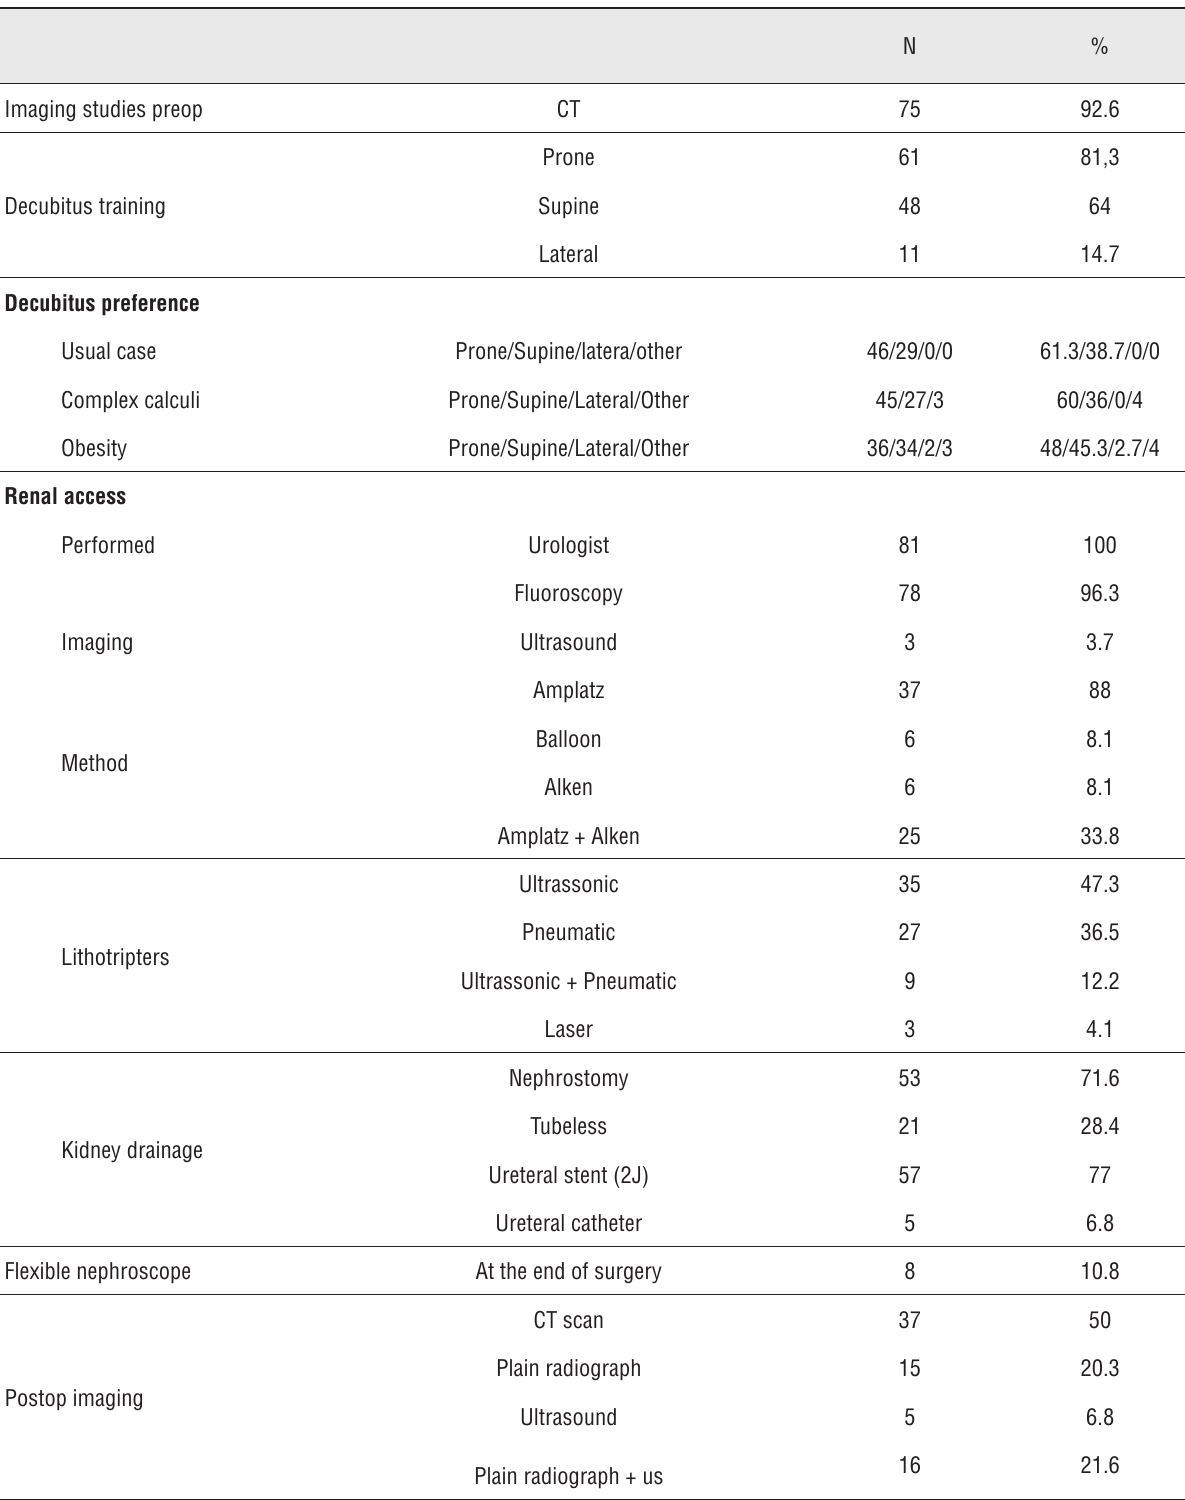
Table 3 - Differences in operative procedures and surgeon